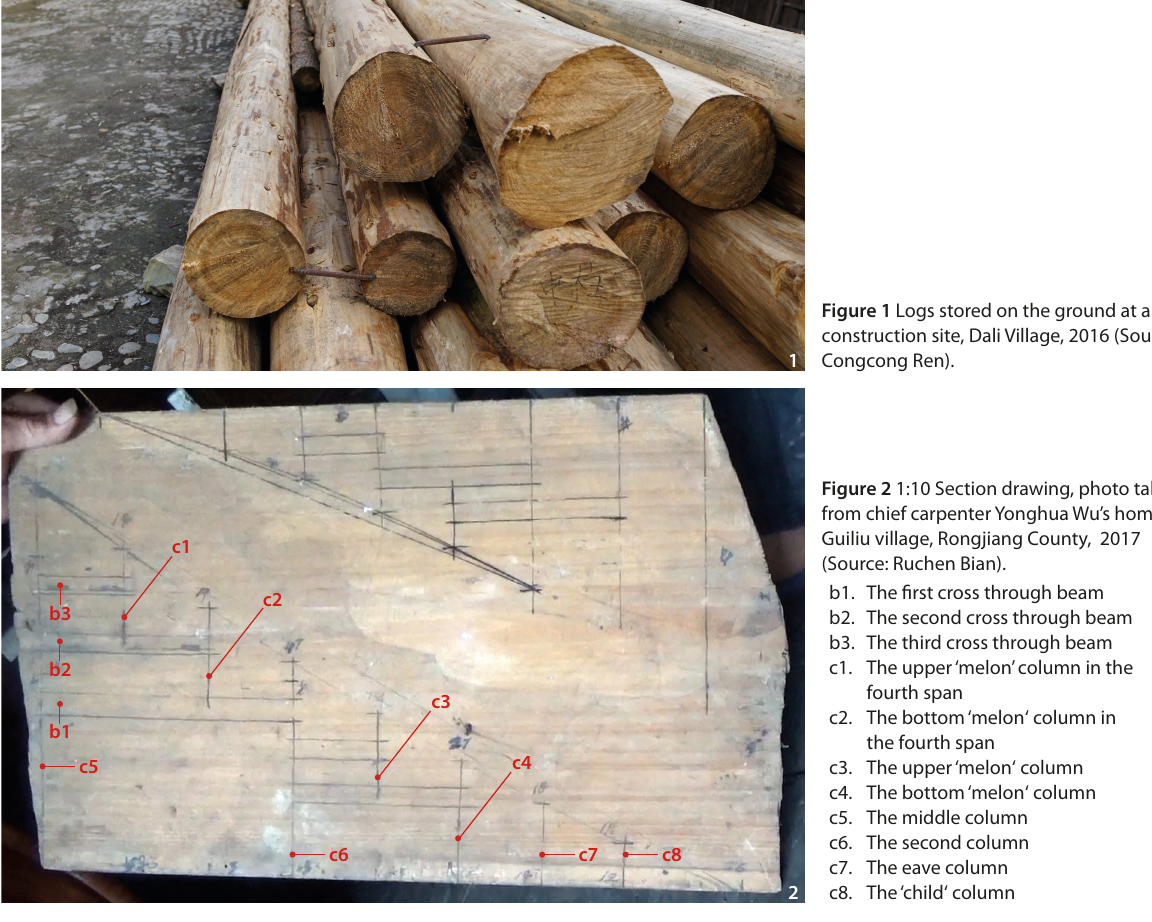
Figure 1 Logs stored on the ground at a construction site, Dali Village, 2016 (Source: Congcong Ren).